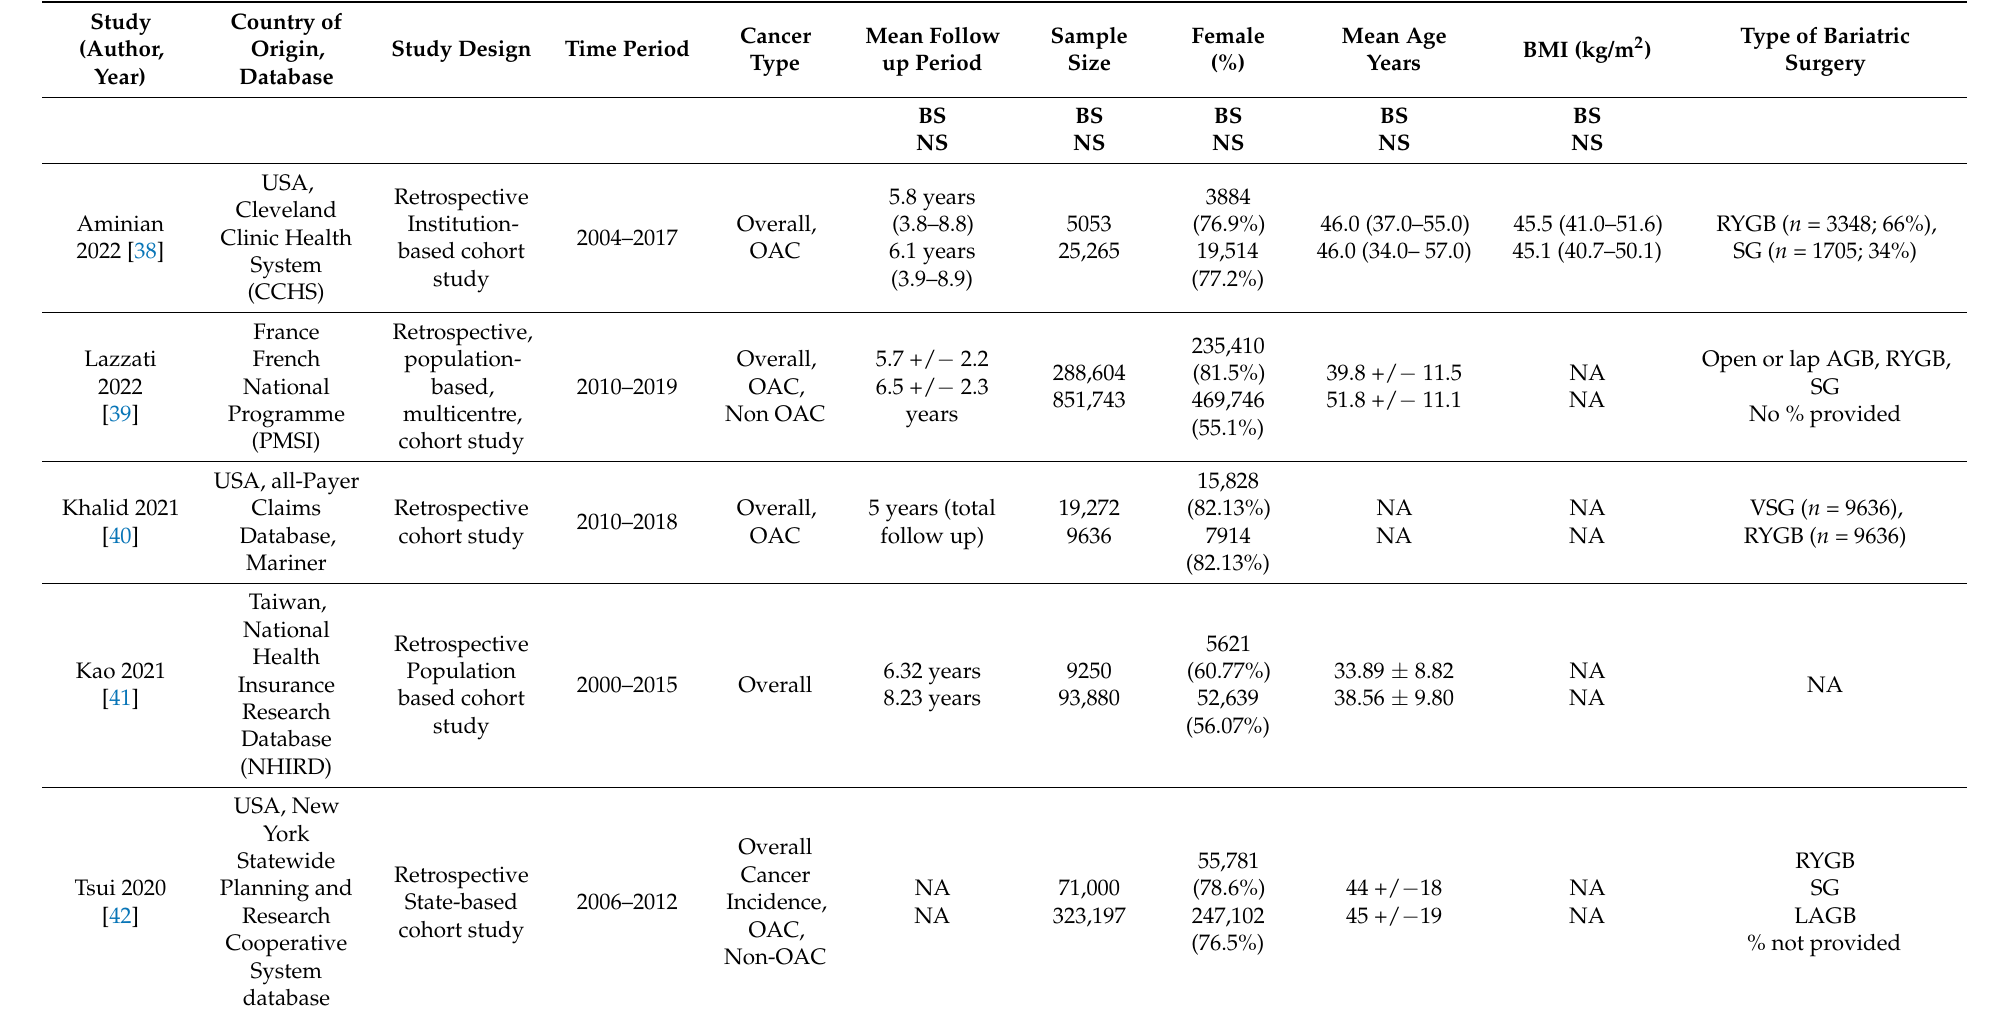
Table 1. Characteristics of the studies included in the meta-analysis